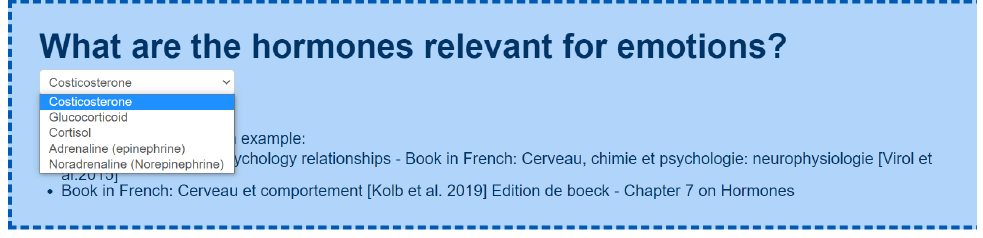
Figure A4. Example of a subset of the taxonomy of hormones [59].